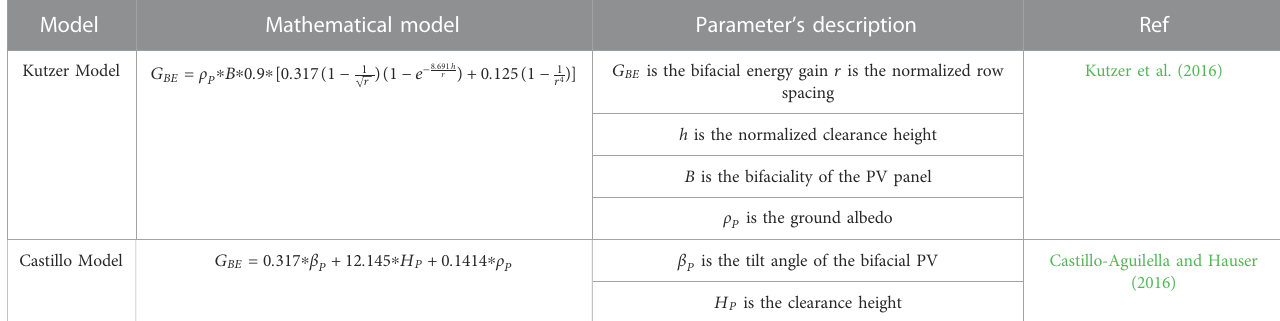
TABLE 3 An illustration of different empirical models for bifacial solar PV systems.